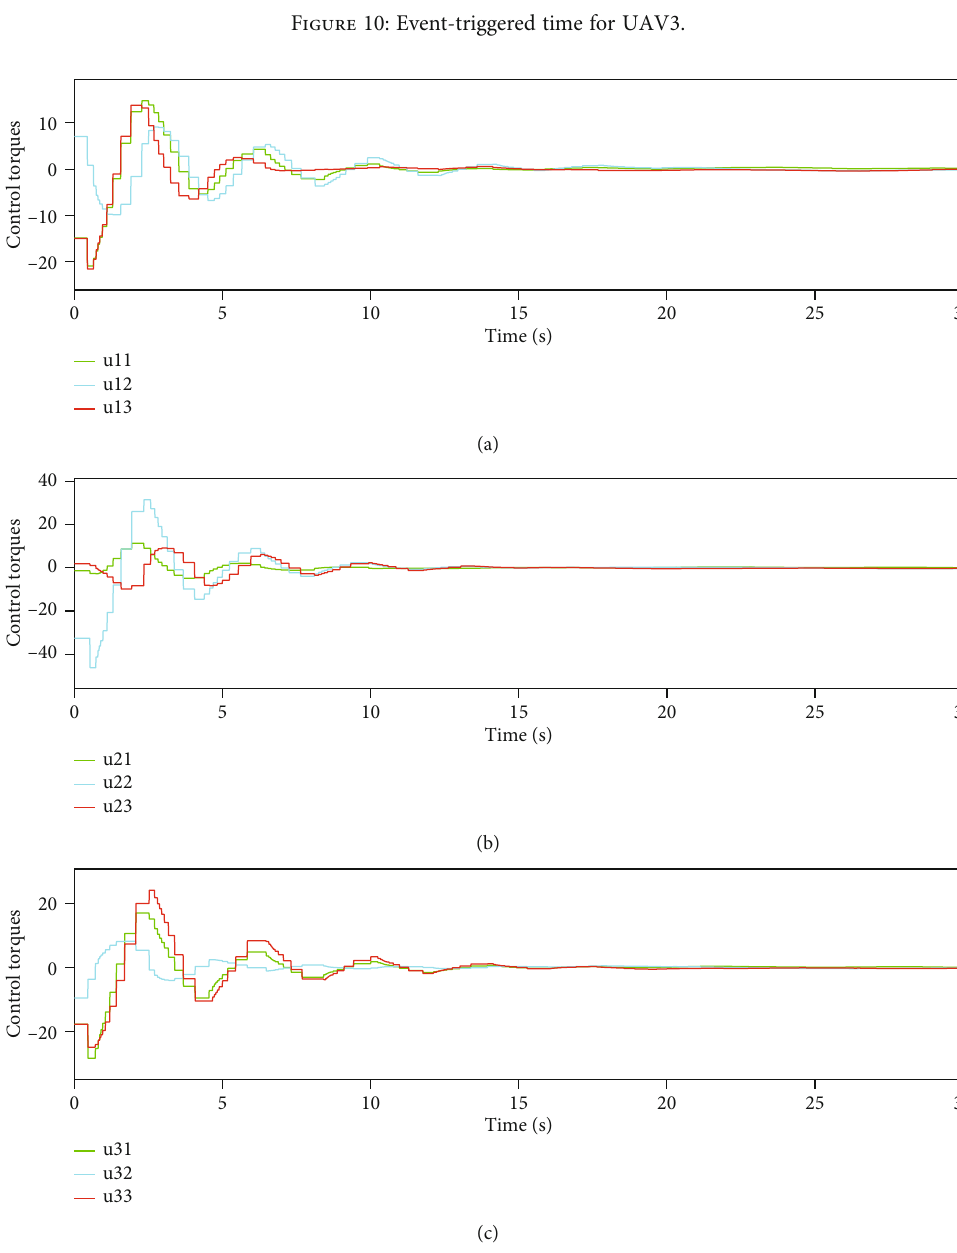
Figure 11: Control